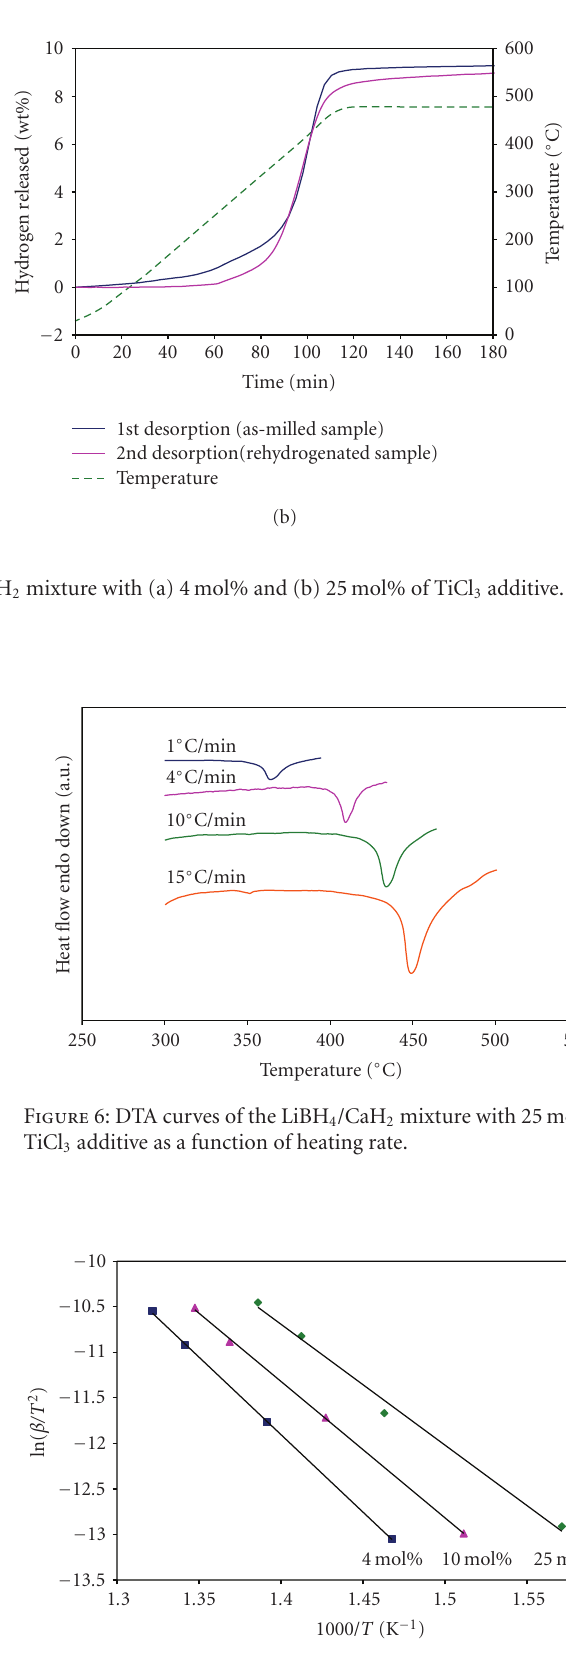
Figure 7: Activation plots using Kissinger equation for the LiBH 4 /CaH 2 mixture with 4, 10, and 25 mol% of TiCl 3